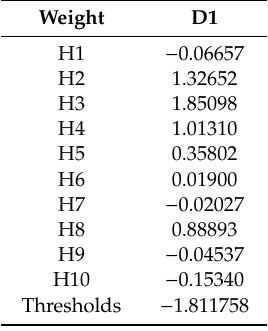
Table 6. Hidden layer to output layer weights and